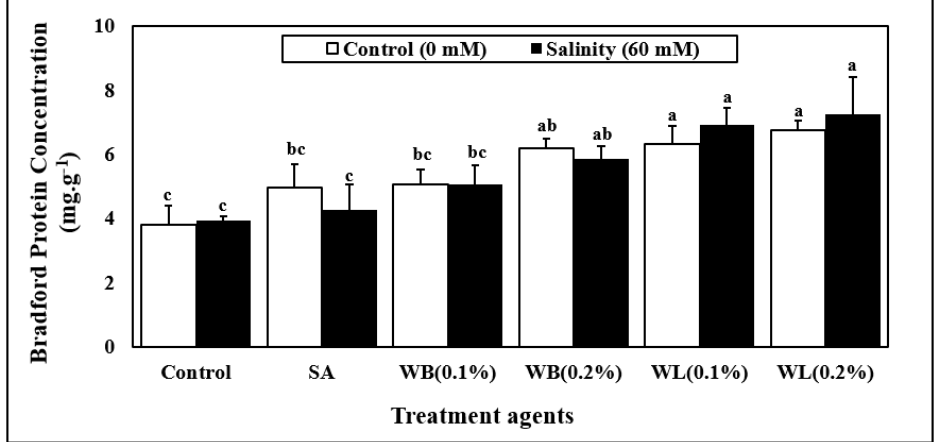
Reported data are means of 4 independent biological replicates. Different letters indicate significant differences between means according to Tukey’s HSD test ( p < 0.05). For two-way ANOVA results and the HSD scores used to separate the means, see Table 1.